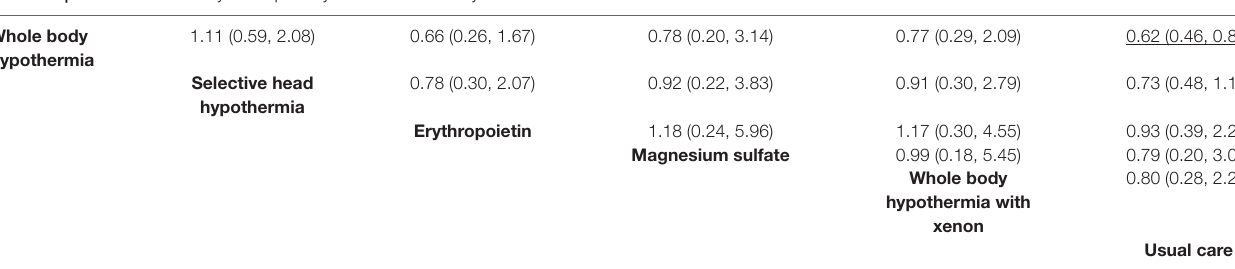
TABLE 2 | Network meta-analysis for primary outcomes mortality. Whole body